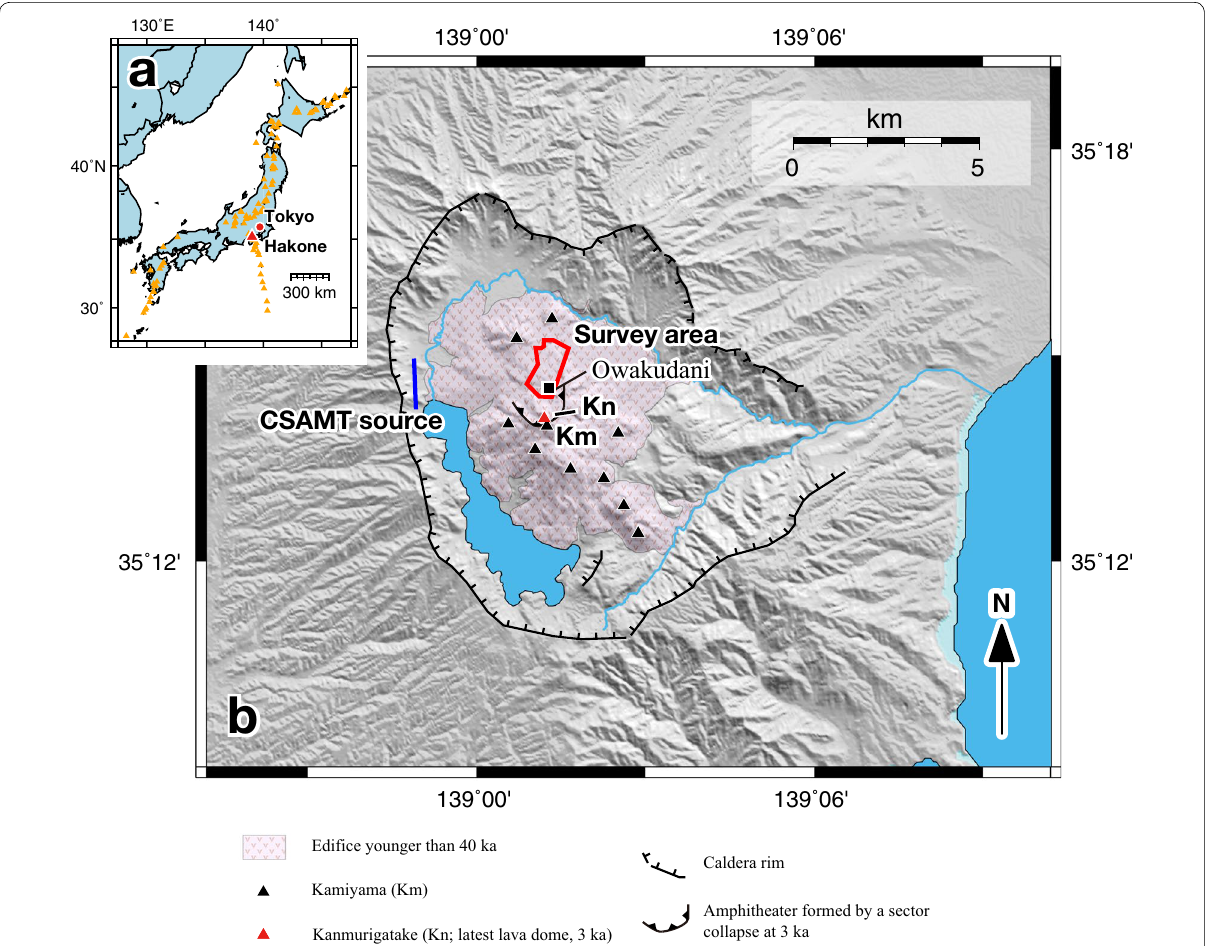
Fig. 1 Index map of Hakone volcano and survey area of this study. The location of the transmitter (source) and survey areas are also